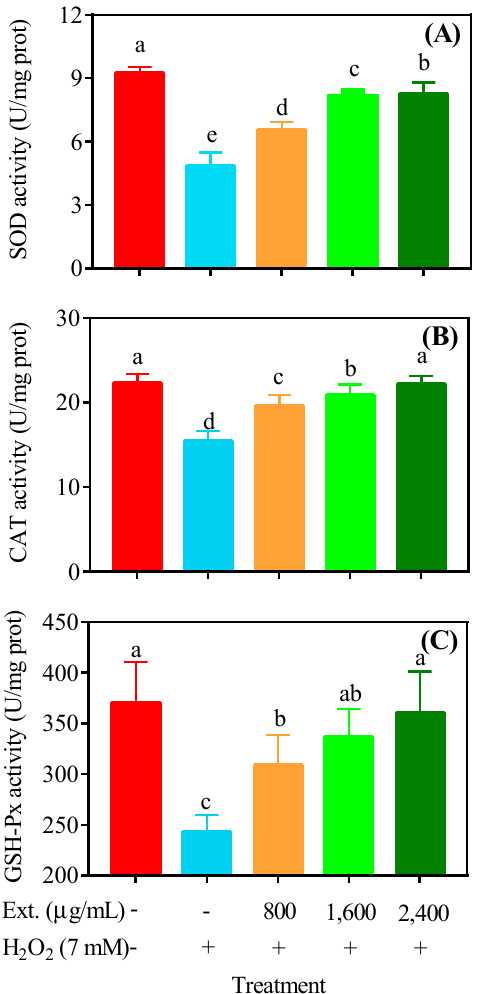
Figure 4. Antioxidant enzyme activities. L − O2 cells received different treatments and were lysed to evaluate the activities of SOD ( A ), CAT ( B ) and GSH − Px ( C ). Ext.: chrysanthemum extract. The lower case letters indicate significant difference at p < 0.05 for different treatments.